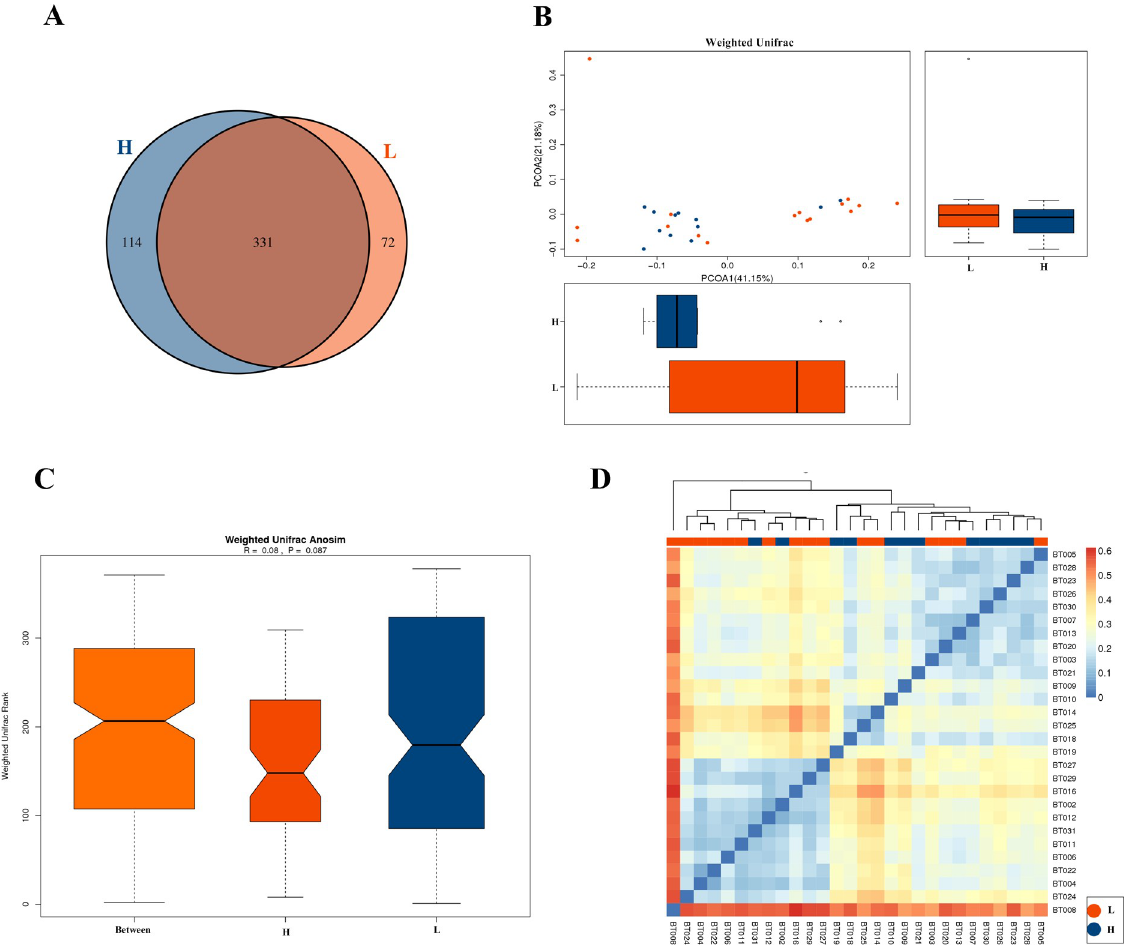
Fig 2. The β -diversity indexes of the faecal microbiota in the samples of the higher-level athletes (H) and lower-level athletes (L). (A) A Venn analysis of bacterial OTUs. (B) PCOA based on the distance matrix of weighted UniFrac dissimilarity of the faecal microbial communities in the H and L groups. The axes represent the two dimensions explaining the greatest proportion of variance in the communities. Each symbol represents a sample: H group (blue) and L group (red). (C) The differences between and within the H and L groups were assessed using one-way ANOSIM. Box plots from the left to the right represent the weighted UniFrac distance between the samples of the H group and the L group, the weighted UniFrac distance of the samples in the H group and the weighted UniFrac distance of the samples in the L group. R values and p values show the community variation between the compared groups. (D) A heatmap with weighted UniFrac phylogenetic distances based on phylotype among samples. The clustering at the top of the figure represents the hierarchical clustering based on the distance between samples. The colour of the grid represents the distance between samples, and the colour corresponds to the icon. The colour from blue to red indicates that the distance between samples increases gradually.